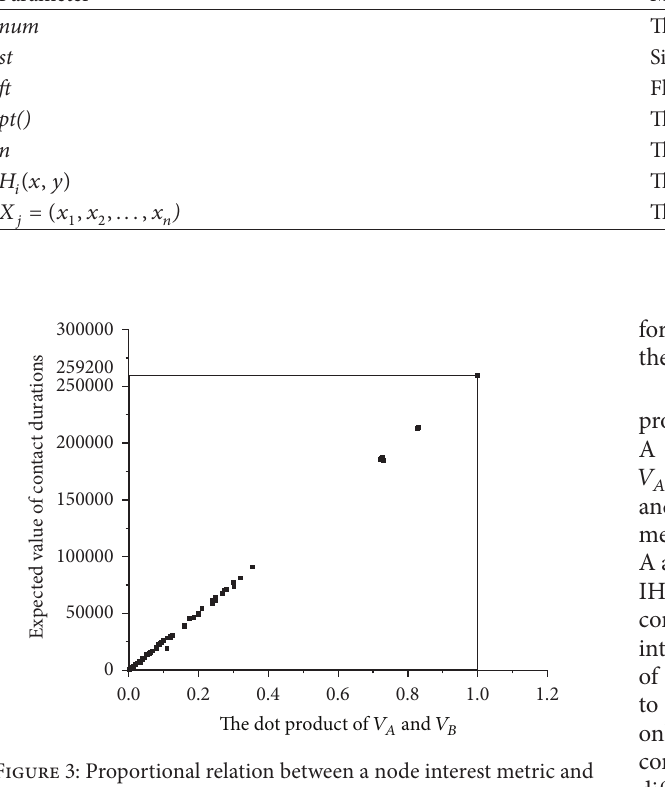
Figure 3: Proportional relation between a node interest metric and a social relationship